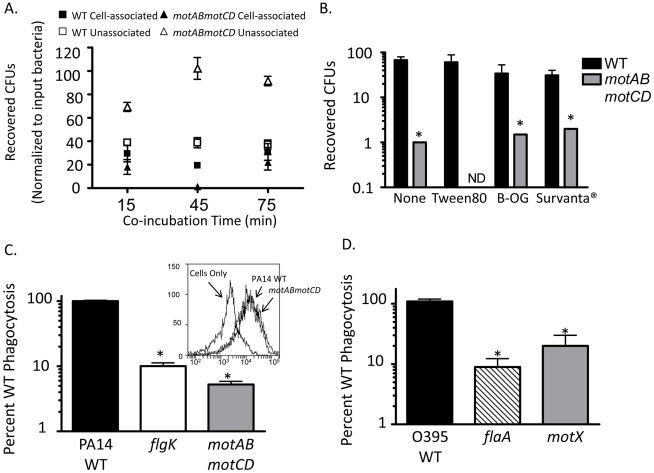
Microbiocidal activity and limited bacteria-cell contact does not provide for decreased phagocytic clearance of non-swimming bacteria.(A) Adherent murine peritoneal macrophages were co-incubated with PA14 WT or motABmotCD and cellular associated bacteria and non-associated bacteria were quantitatively assessed at the indicated time points. (B) BMDCs were co-incubated with WT or motABmotCD in the presence or absence of 0.01% Tween80, 0.01% beta-octyl glucoside, or 2% Survanta, and assayed by gentamicin protection assay for relative bacterial phagocytosis. (C, inset) GFP-expressing PA14 WT or motABmotCD were centrifuged onto BMDCs and immediately fixed and analyzed by FACs for cellular association. Phagocytic cells in the absence of bacteria are shown as background. (C) P. aeruginosa PA14 WT, flgK, or motABmotCD, or (D) V. cholerae O395 WT, flaA, or motX were centrifuged onto BMDCs or peritoneal macrophages, respectively, and assayed by gentamicin protection assay. N≥5, *p<0.05 as compared to WT.